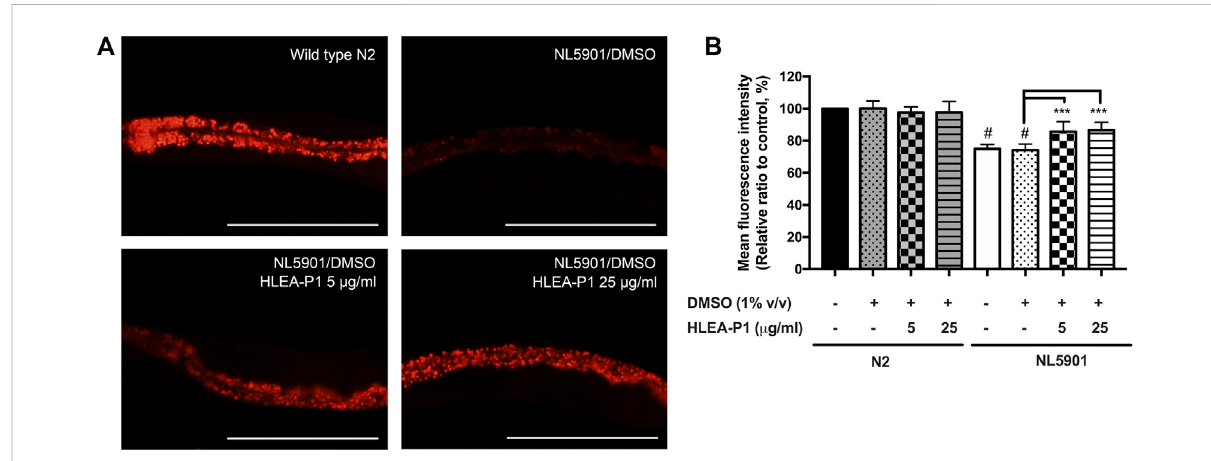
FIGURE 5 Effect of HLEA-P1 on lipid restoration in transgenic NL5901 worms expressing α -synuclein. (A) Representative Nile red fl uorescent images of wild-type N2, C. elegans NL5901 and C. elegans NL5901 treated with HLEA-P1 at 5 and 25 μ g/ml. (B) Graphical representation for Nile red fl uorescent signal. The data are presented as mean ± SEM (with three independent replicates, n ≥ 30 number of animals per replicate). The hash (#) indicates a signi fi cant difference between wild-type N2 and NL5901 worms ( p < .05). The asterisk (*) indicates signi fi cant difference between untreated group (NL5901/DMSO) and HLEA-P1-treated groups, *** p < .001. Scale bar is 200 μ